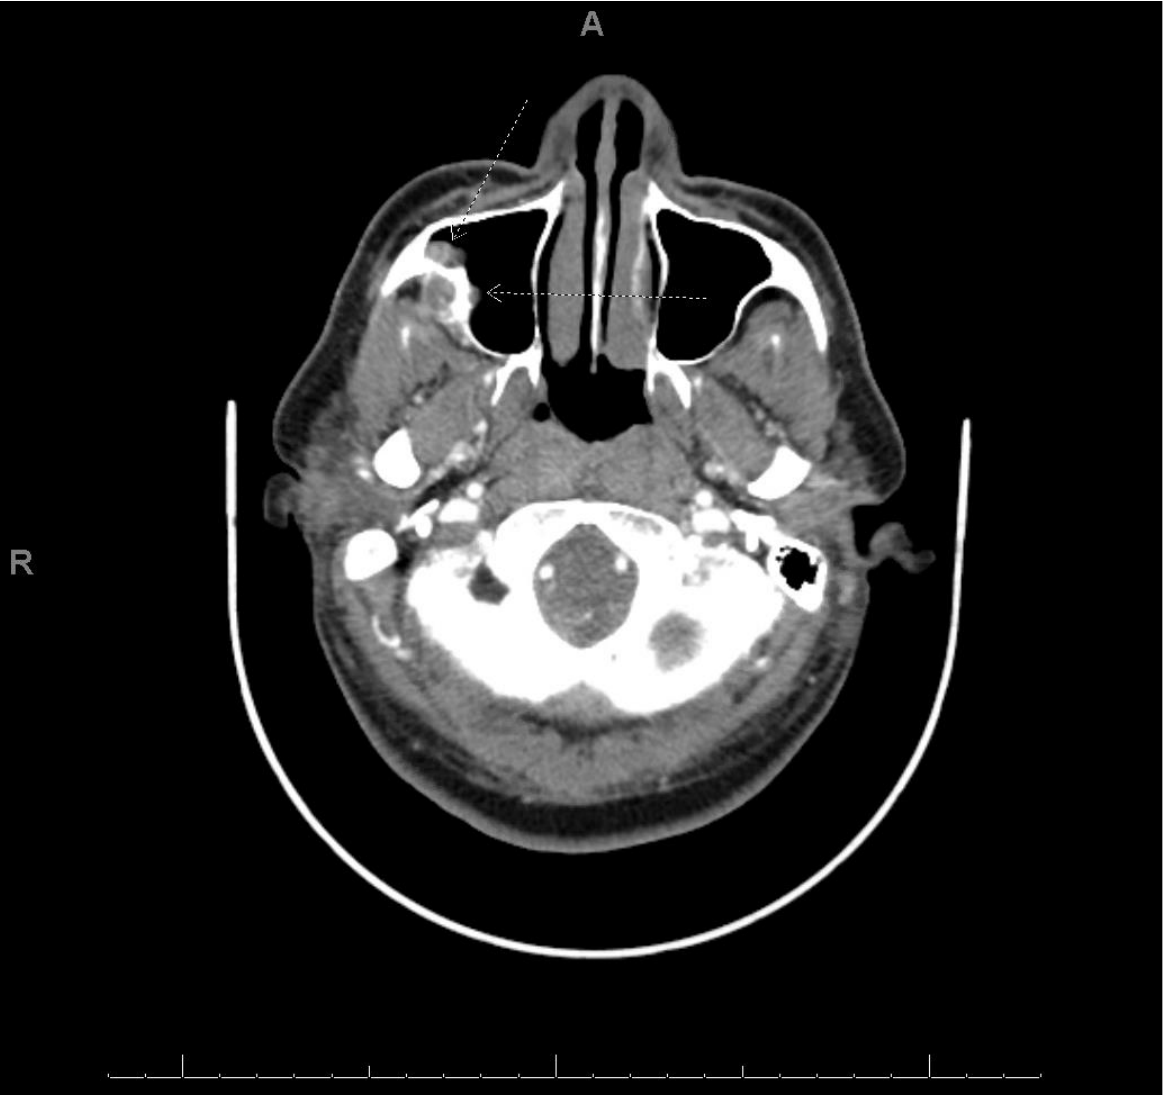
Figure 8. Heterogeneous soft tissue mass involving lateral wall of right maxilla and alveolar process axial view.